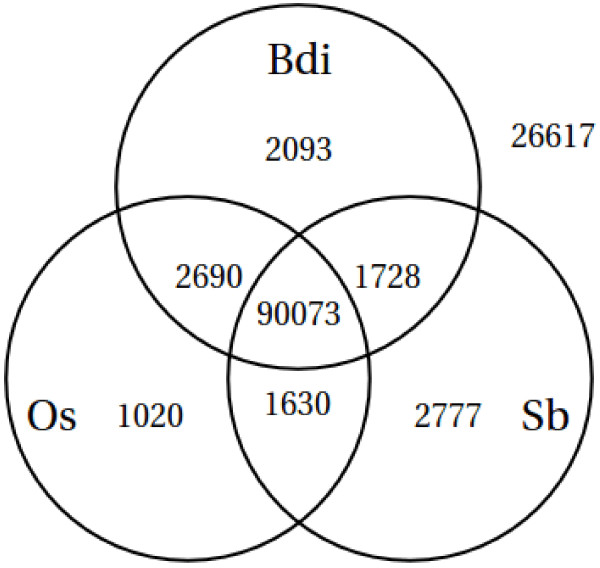
Assembled transcripts in common with other grasses. (Bdi: Brachypodium, Os: Oryza sativa, Sb: Sorghum).